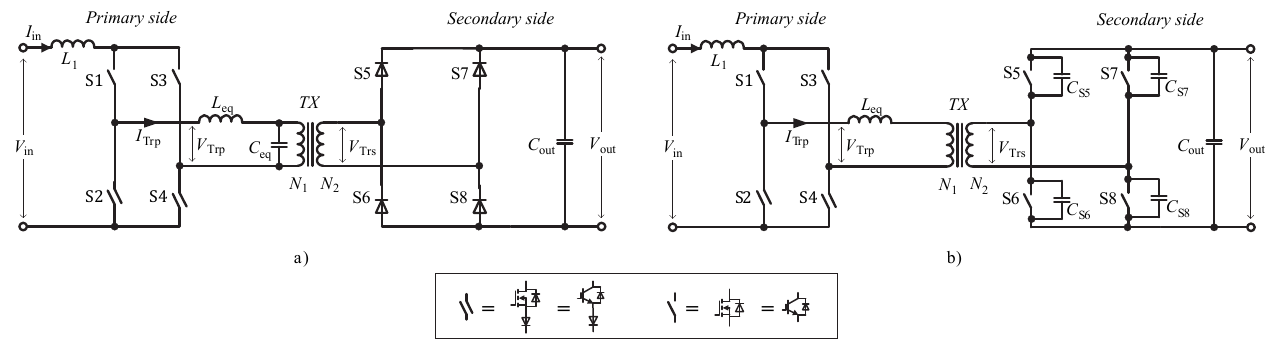
Fig. 1. Topology of the asymmetric converters proposed: ARPC (a), ASMB (b).